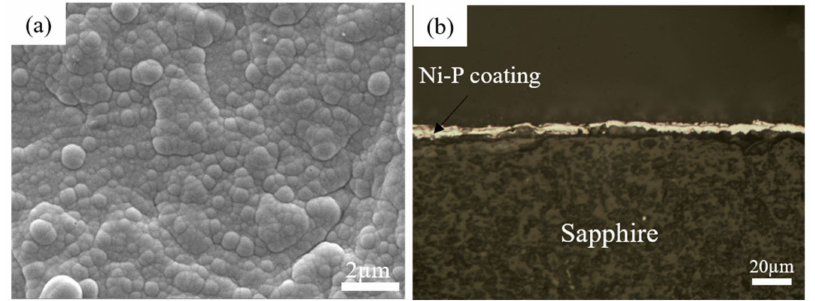
Figure 4. ( a ) Surface morphology, ( b ) section morphology of Ni-P